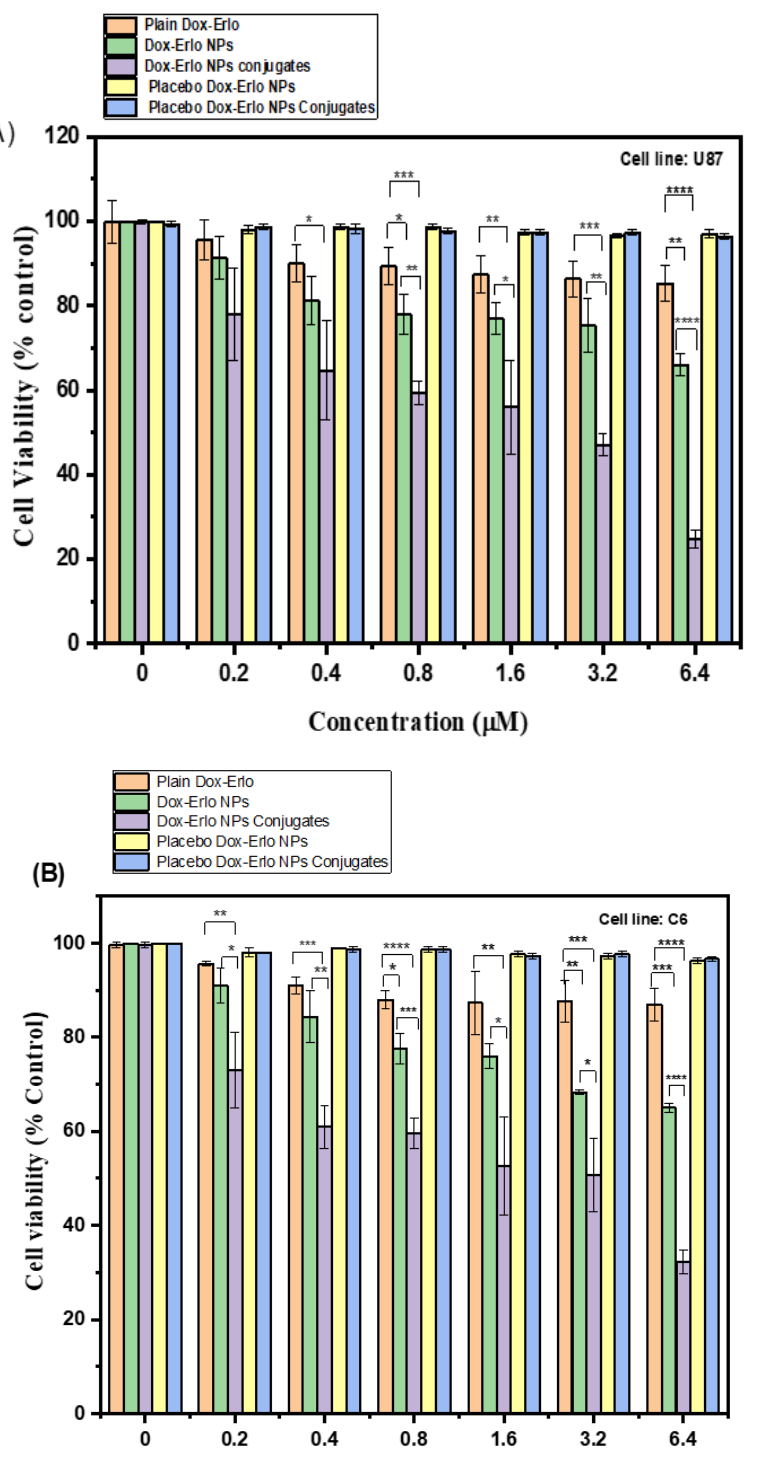
Figure 10. The percentage cell viability following 24 h of treatment with various doses of plain Dox–Erlo, Dox–ErloNPs, Dox–Erlo-NP conjugates, placebo Dox–Erlo NPs, and placebo Dox–Erlo-NP conjugates on U87 ( A ) and C6 ( B ) glioma cell lines. The experiments were performed in triplicate with mean ± S.D ( n = 3). Significance value * ( p < 0.05), ** ( p < 0.01), *** ( p < 0.001), **** ( p < 0.0001) relative to pure Dox-Erlo.